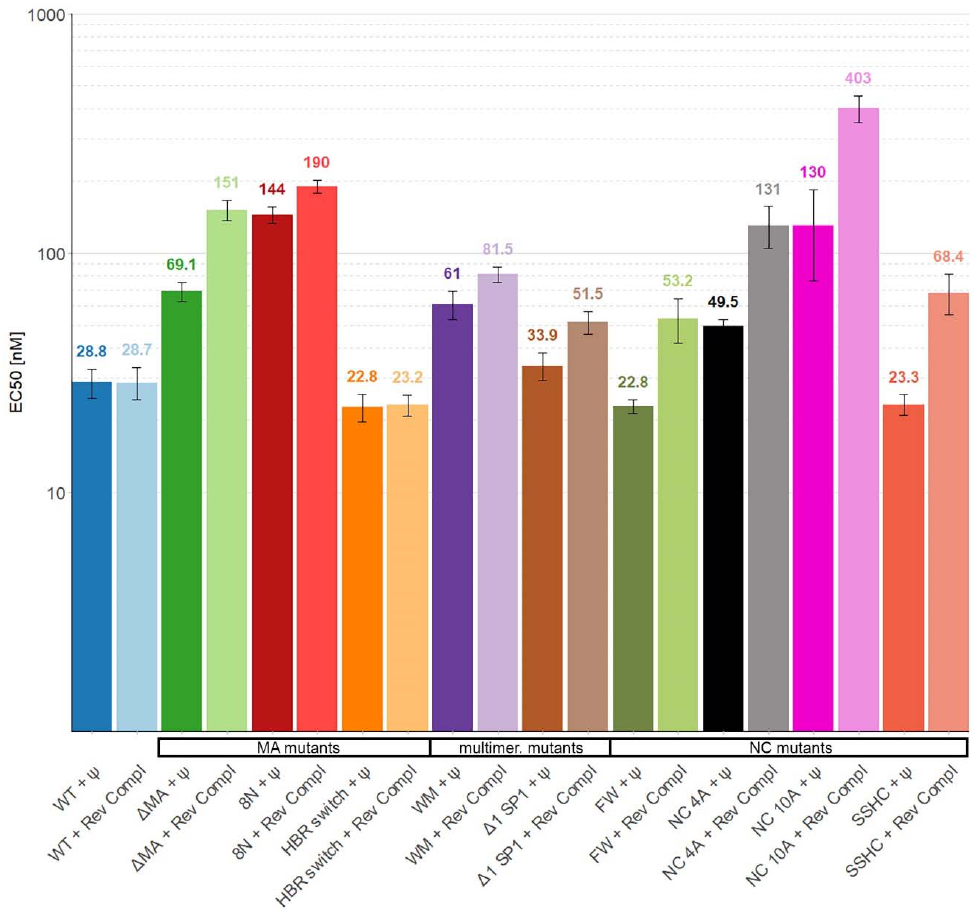
Figure 2. The affinity of WT Gag Δ p6 and mutants for Ψ and reverse complement RNAs in buffer containing near ‐ physiological salt (100 mM). None of the differences between binding to Ψ and reverse complement RNAs for individual proteins is statistically significant. Error bars represent 95% confidence interval of EC50 values.